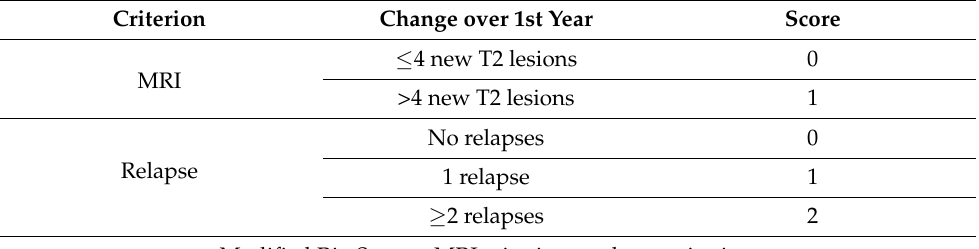
Table 1. Modified Rio score scoring criteria